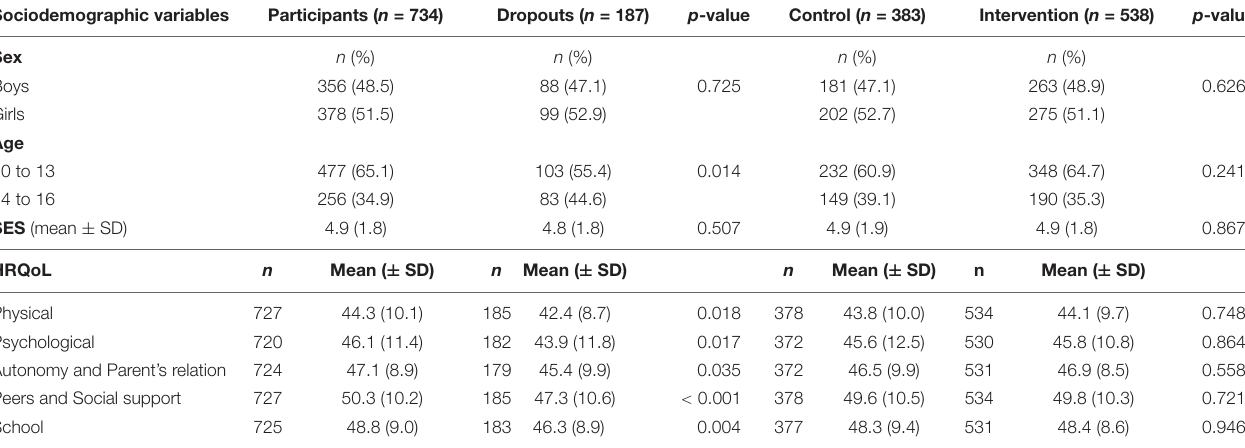
TABLE 1 | Students’ characteristics at baseline according to group (intervention and control) and in participants and dropouts of the Movimente Program, 2017. Sociodemographic variables